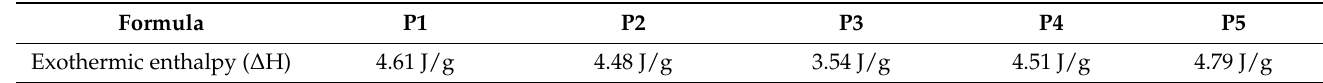
Table 5. Exothermic enthalpy corresponding to the exothermic peak of Samples P1–P5 near 340 ◦